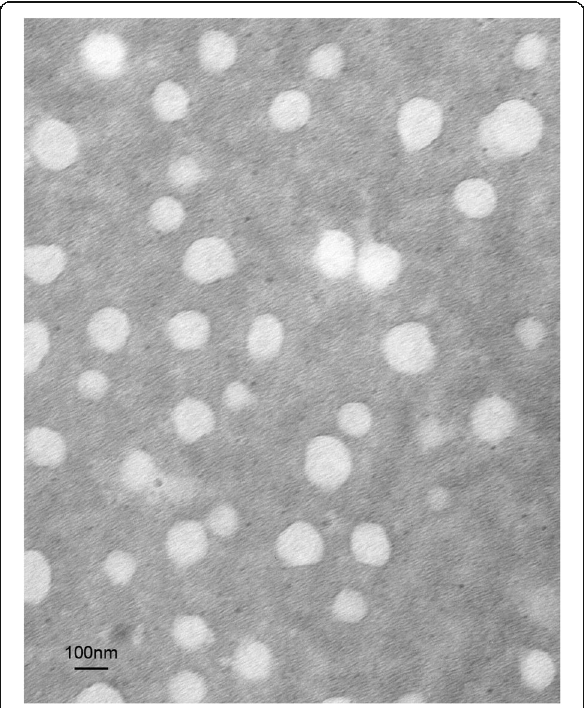
Fig. 2 The characteristic of PEG-PCCL: TEM image. Scale bars were 100